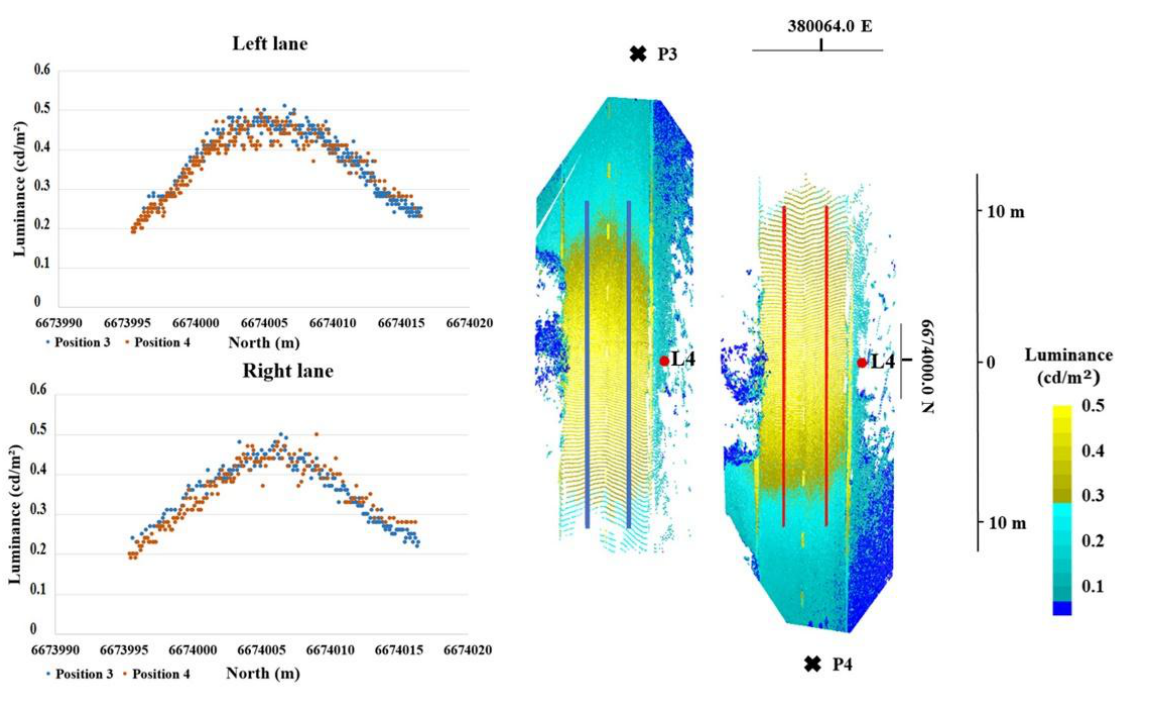
Figure 7. The ( left) and ( right) lane luminance values in the longitudinal direction along the centreline of each lane. The scatter plot shows the values captured from different directions (position 3, P3; and position 4, P4). The position of the lamp pole and samples are marked in red and blue. Coordinates are presented in